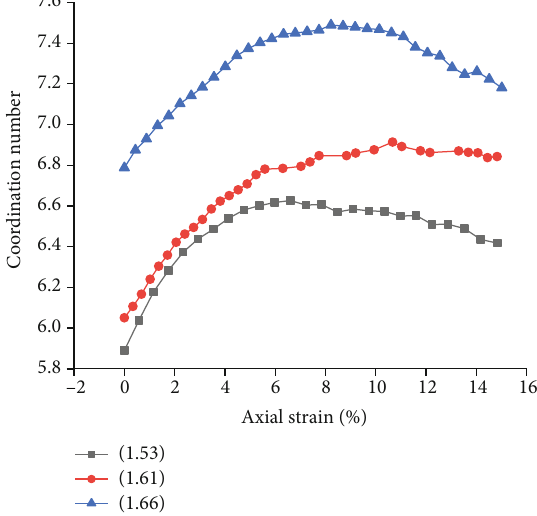
Figure 10: Coordination number changes of di ff erent dry density models during